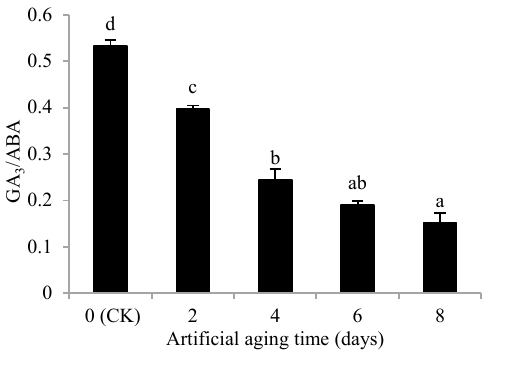
Figure 3 Effects of artificial aging on endogenous gibberellin (GA e values are shown as mean ± SE . Different letters above the bars denote significant differences ( p ≤ 0.05) with Duncan’s test within the same planting conditions.